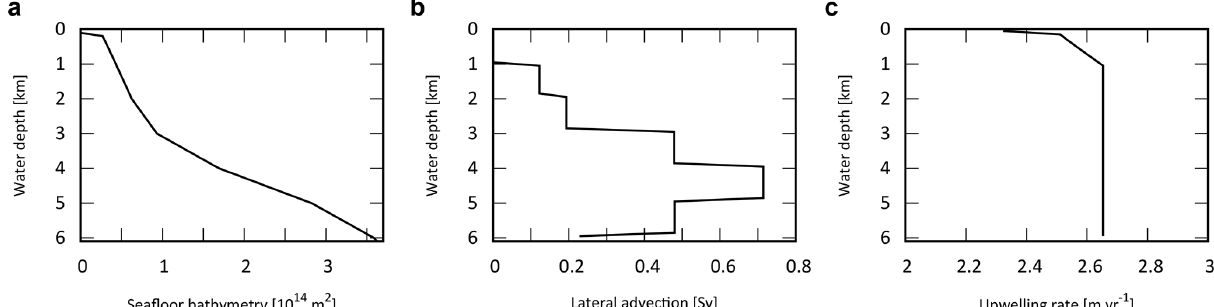
Figure 4. Ocean bathymetry and water transport. (a) Seafloor topography (cumulative seafloor area) (Millero, 2006) adopted in the CANOS- GRB model. (b) Lateral water advection from HD to LD section assumed in the standard run (in Sv). Total advection rate ˙ V was set at 20Sv. (c) Upwelling rate in the LD region (in myr − 1 ) of the standard